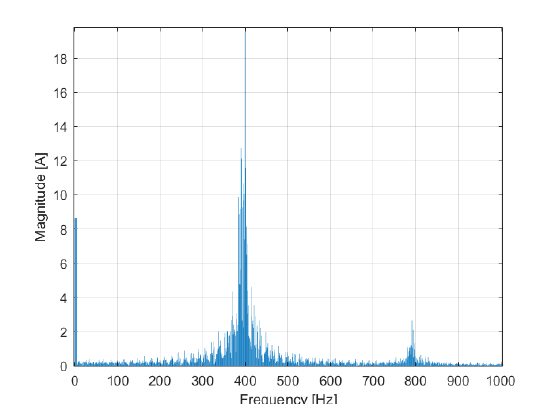
Figure 17. Fourier analysis of the d-axis current in the synchronous injection